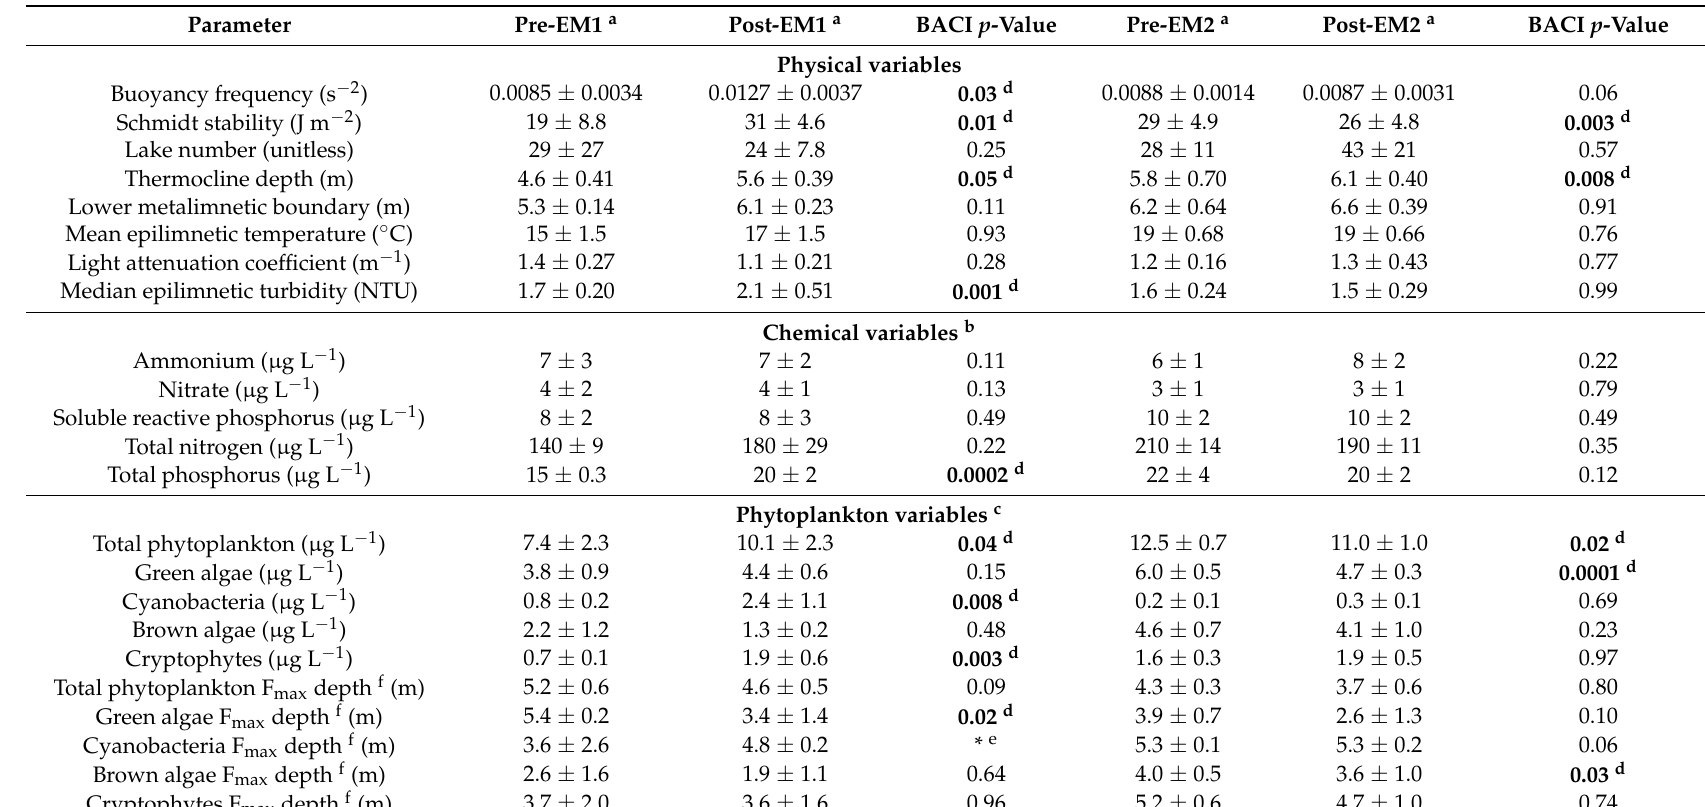
Table 1. Results of Before-After-Control-Impact (BACI) analysis for physical, chemical, and biological